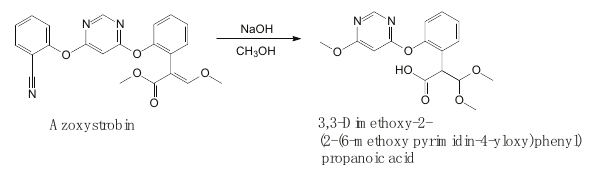
FIGURE 4 | Proposed degradation pathway of azoxystrobin via the hydrolysis reaction (based on Zhang et al., 2011). and light in aqueous conditions and revealed that it readily forms acid metabolites. The study emphasized that abiotic factors have significant effects on the dissipation of kresoxim-methyl under aqueous conditions. Similarly, photolysis has also been reported as the main degradation pathway of trifloxystrobin under field conditions, and the number of sunshine hours is the key influencing factor for the photolysis process (Wang et al., 2015). Trifloxystrobin residue was found in tomato, whereas its metabolite trifloxystrobin acid was observed in soil (Wang et al., 2014). Reddy et al. (2013) reported that the organic matter content, microbial population and soil moisture